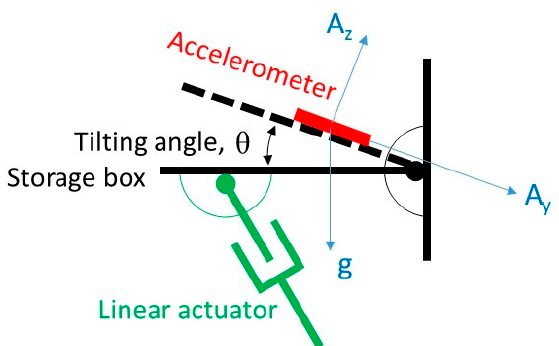
where A z and A y are the acceleration on the z -axis and y -axis, respectively. The measurement setup using an accelerometer is shown in Figure 6.